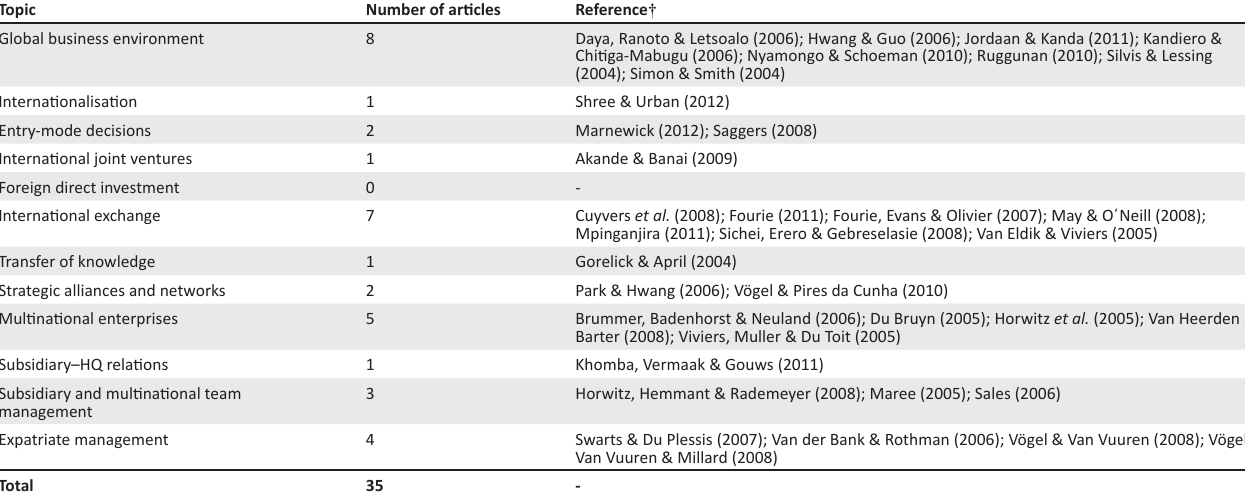
TABLE 3: International management articles by topic.